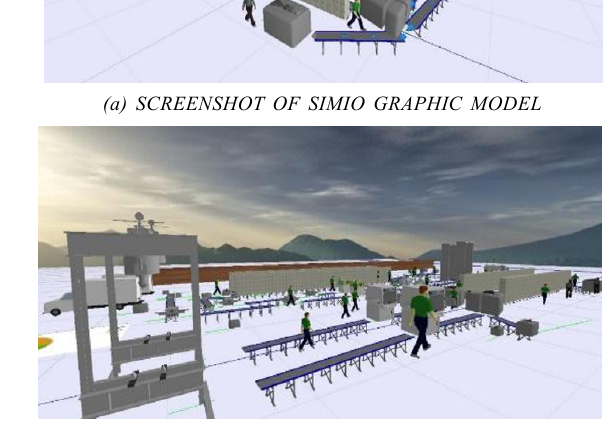
(b) SCREENSHOT OF SIMIO MODEL IN VERY START OF LINE